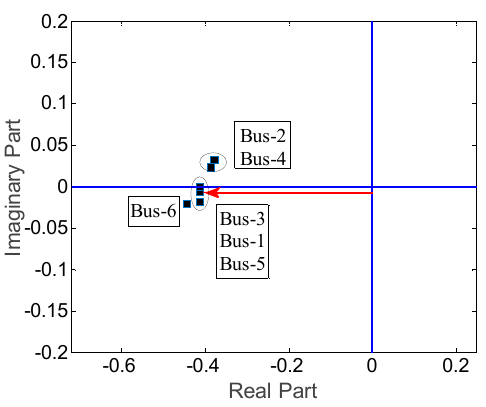
Figure 9. Nodal voltage mode shape of the 42.7 Hz resonance mode. Table 6. Participation matrix of the 42.7 Hz resonance mode.